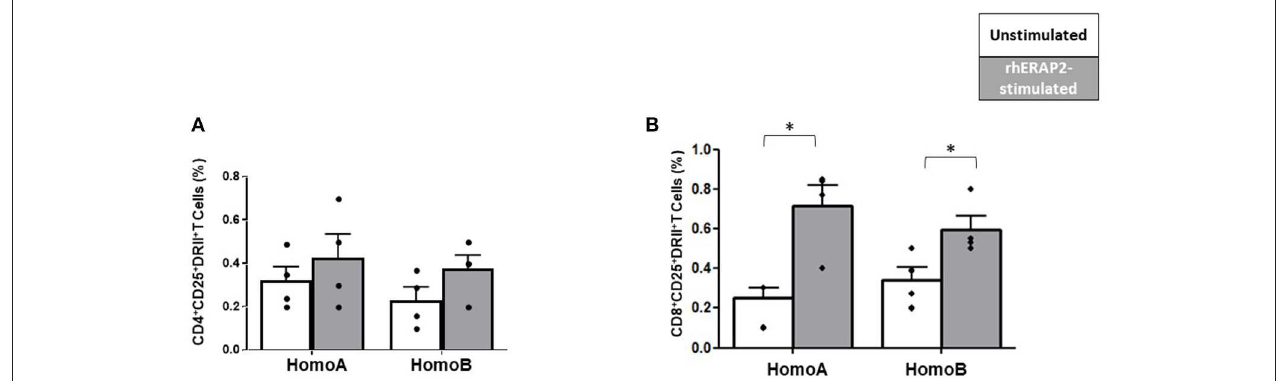
FIGURE 5 | The percentage of CD25 + HLA-DRII + CD8 + was increased in in vitro rhERAP2-treated PBMCs. CD25 + HLA-DRII + CD4 + T cells (A) or CD25 + HLA-DRII + CD8 + T cells (B) in 24 h-rhERAP2 untreated (white bars) or treated (gray bars) PBMCs from 4 HomoA and 4 HomoB subjects. Mean values and SEM are shown. * p < 0.05.